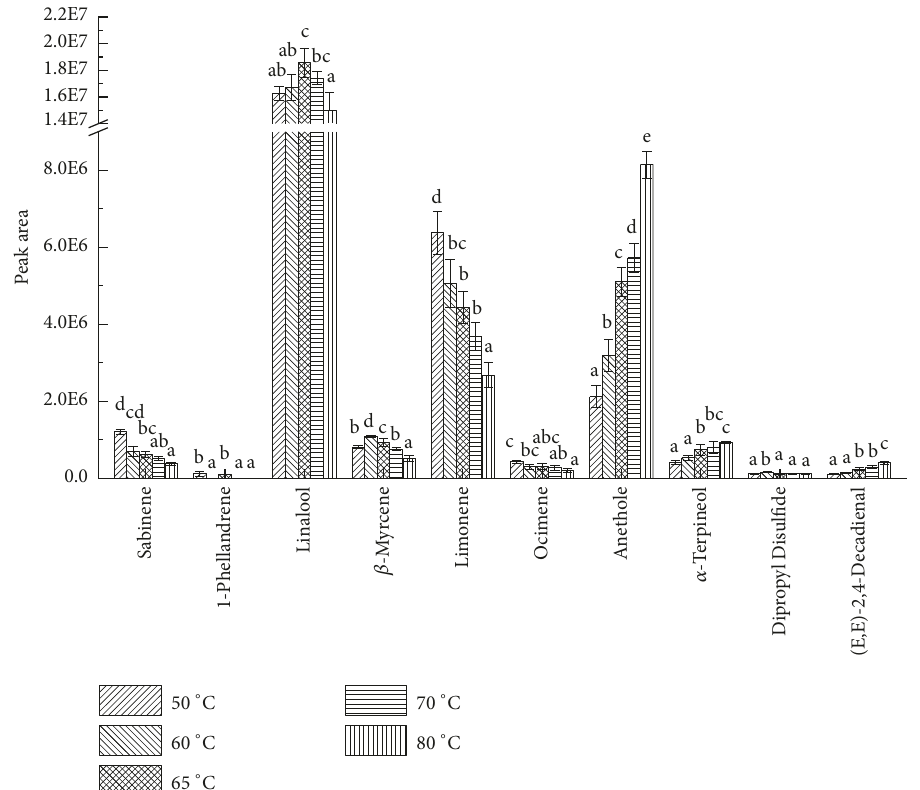
Figure 7: Effects of extraction temperature on peak areas of key aroma compounds. English letters “a”, “b”, “c”, “d”, “e” indicate Duncan’s multiple range test among peak areas of the five extraction temperatures. Data in the same compound marked with different letters mean significant difference ( p < 0.05) and the same letters denote not significant difference (p < 0.05).